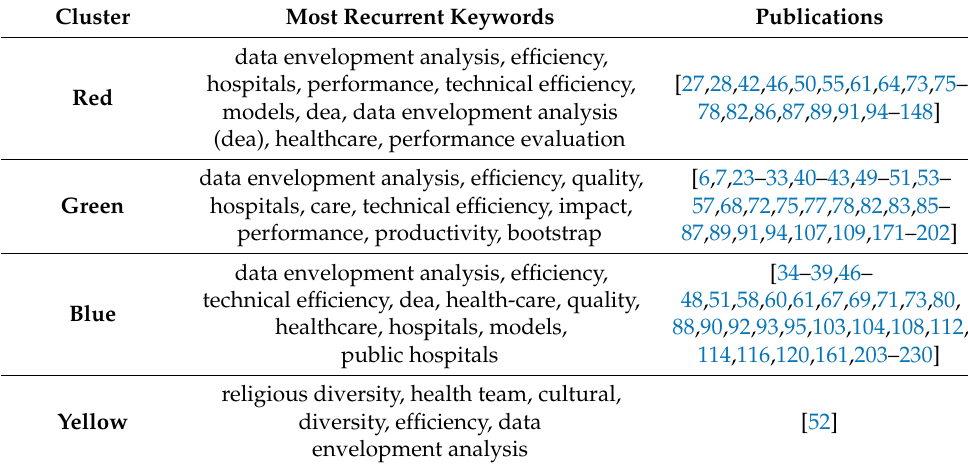
Table 5. Recurrent Keywords reported in the Co-occurrence Networks. Cluster Most Recurrent